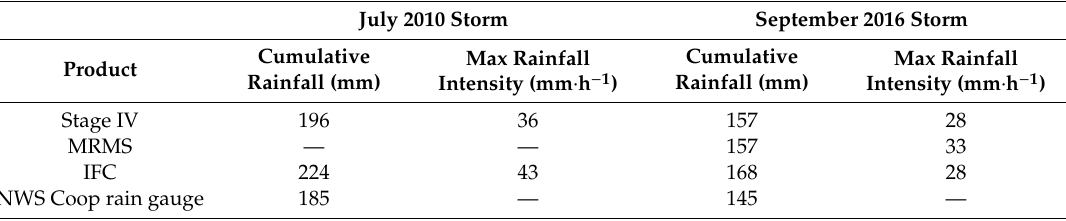
Table 1. Cumulative radar rainfall (mm) computed over Manchester using Stage IV, MRMS, and IFC products and the maximum rainfall intensity (mm · h − 1 ) for the July 2010 and September 2016 storms. The daily rainfall measurements from the NWS Coop rain gauge data near Manchester were compared to the radar rainfall